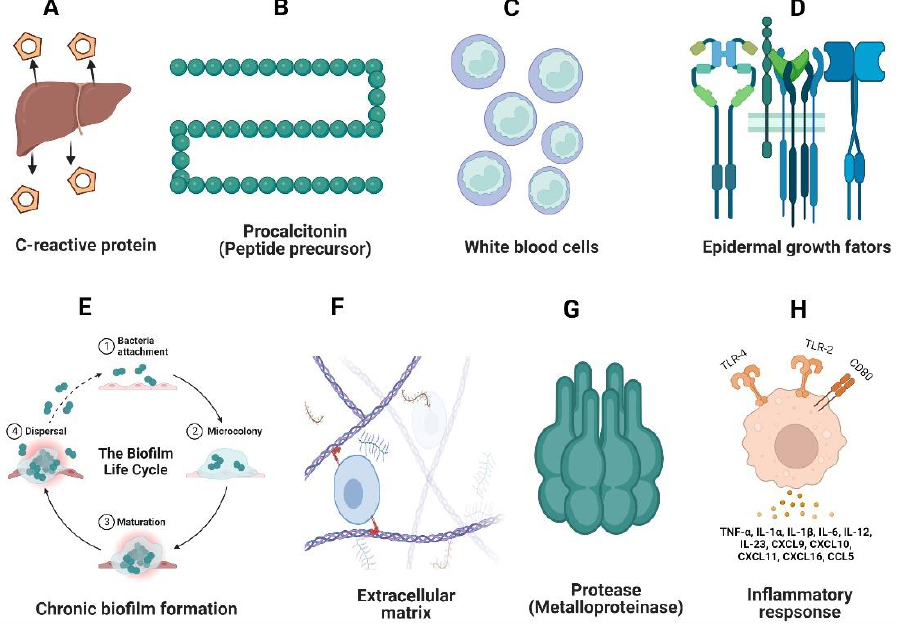
in macrophage-associated proteins and T-cell-mediated immune responses ( H